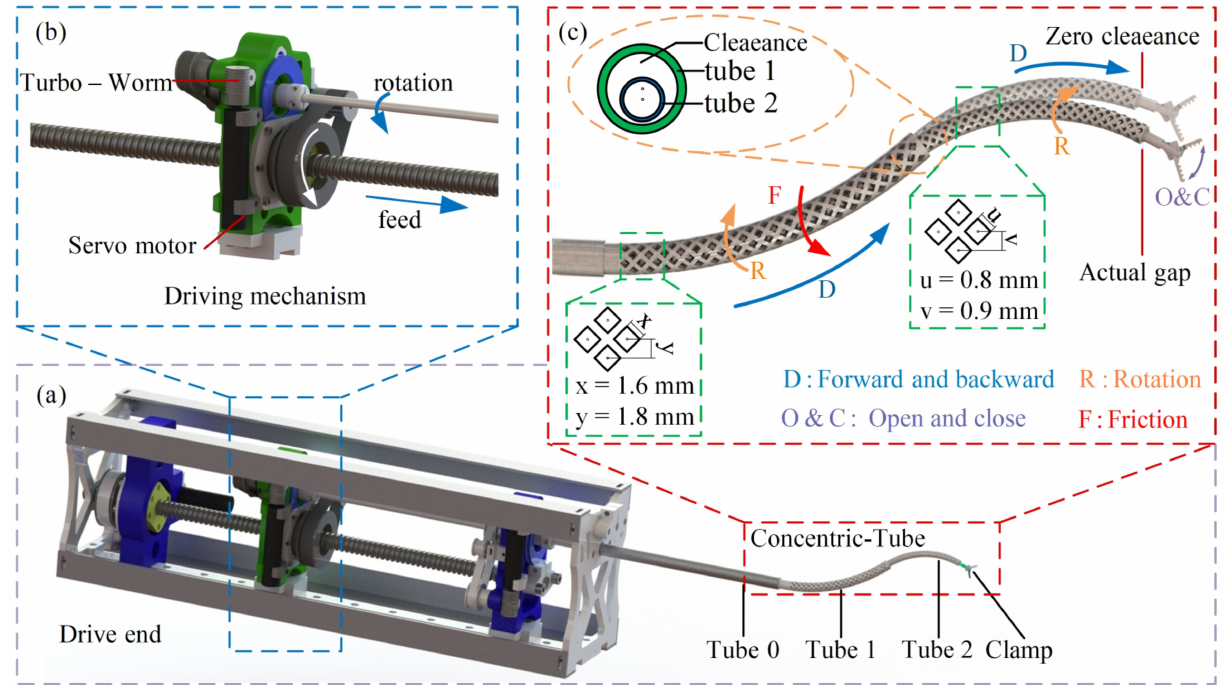
Figure 1. Concentric tube robots: ( a ) overall schematic diagram of concentric tube robots, ( b ) drive module, ( c ) degrees of freedom and